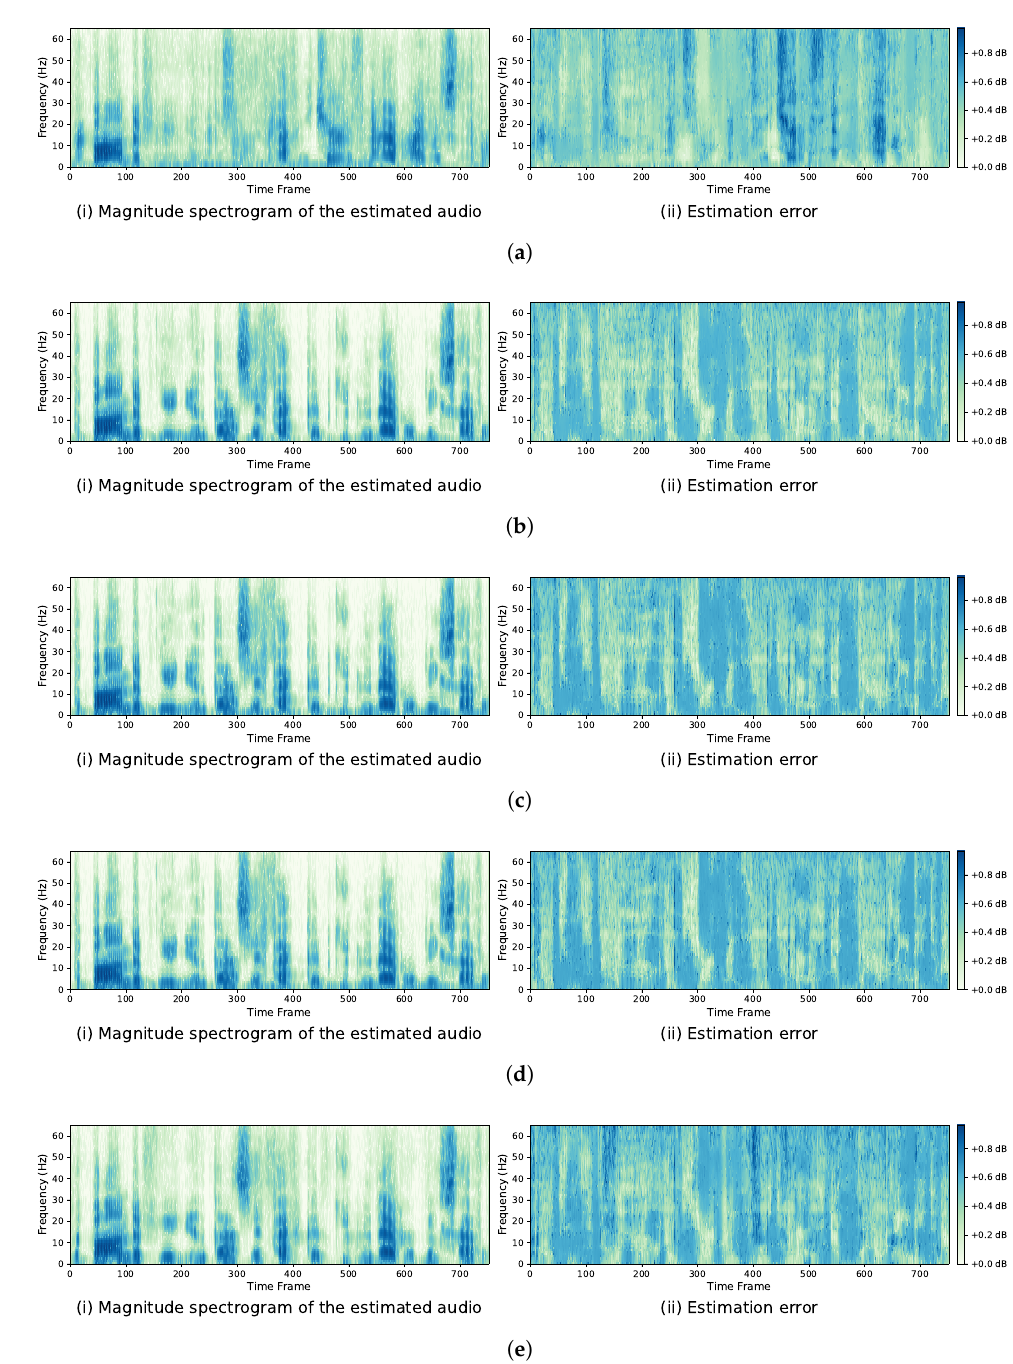
Figure 4. The estimated spectrograms and estimation error diagrams of PITNet model. The x - axis represents the time frame, the y -axis represents the frequency, and the unit of color scale is dB. ( a ) The estimated magnitude spectrogram (i) and the estimation error (ii) of the PITNet model without voiceprint feature integration. ( b ) The estimated magnitude spectrogram (i) and the estimation error (ii) of the PITNet model integrating MFCCs features using DC fusion method. ( c ) The estimated magnitude spectrogram (i) and the estimation error (ii) of the PITNet model integrating MFCCs features using ECC fusion method. ( d ) The estimated magnitude spectrogram (i) and the estimation error (ii) of the PITNet model integrating MFCCs features using CEC fusion method. ( e ) The estimated magnitude spectrogram (i) and the estimation error (ii) of the PITNet model integrating d-vector features using ECC fusion